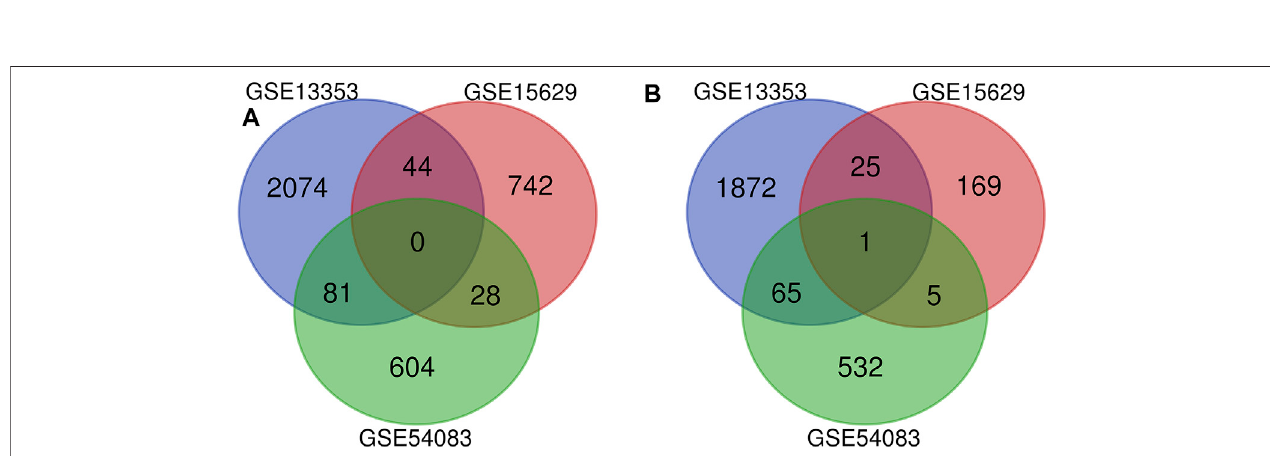
FIGURE 2 | Venn diagrams of the DEGs in all three datasets. (A) 153 down-regulated DEGs screened out from the three datasets; (B) 96 up-regulated DEGs screened out from the three datasets.